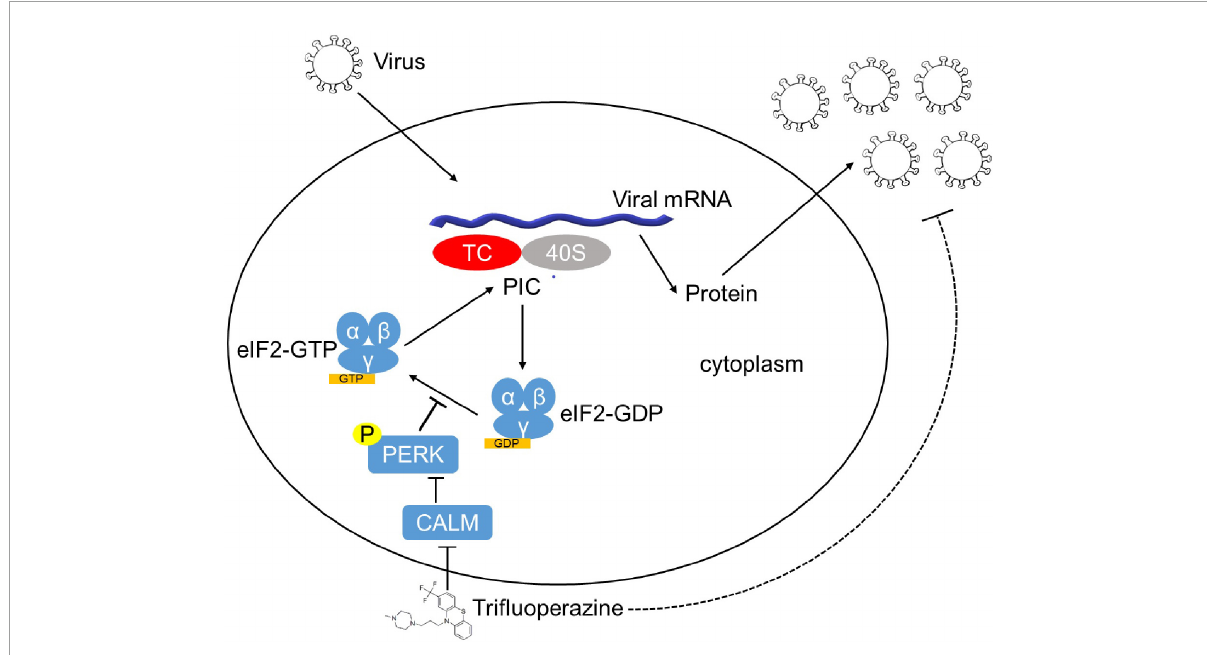
FIGURE6 The model of the mechanism of TFP inhibiting viral replication. After infection, the virus synthesizes proteins in a host cell dependent manner. eIF2 ( α , β , and γ ), a key factor involved in translation initiation, functions to form eIF2–GTP–Met-tRNA iMet TC that binds to 40S subunit. Phosphorylation of eIF2 α mediated by HRI, PKR, PERK, and GCN2 inhibits the conversion from eIF2 · GDP to the active form eIF2 · GTP and reduces TC delivered to the ribosome, resulting in global translation attenuation. FDA-approved drug TFP promotes eIF2 α phosphorylation by targeting CALM in a PERK-dependent manner, which decelerates protein translation and restrains the replication of both RNA and DNA